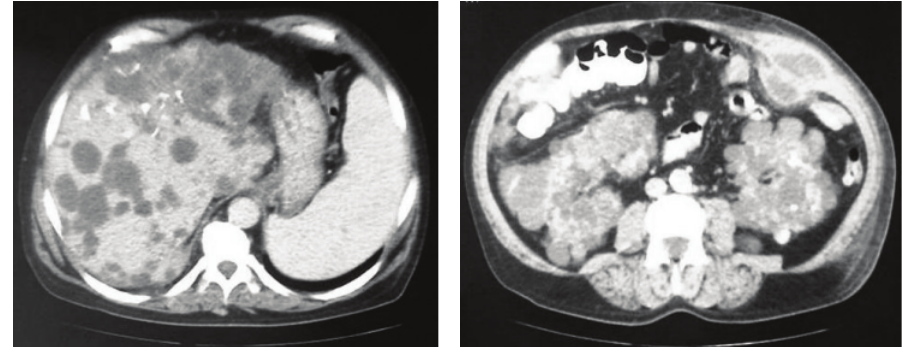
Figure 2: Abdominal Computed Tomography: diffuse involvement of polycystic disease in both kidneys, liver, and